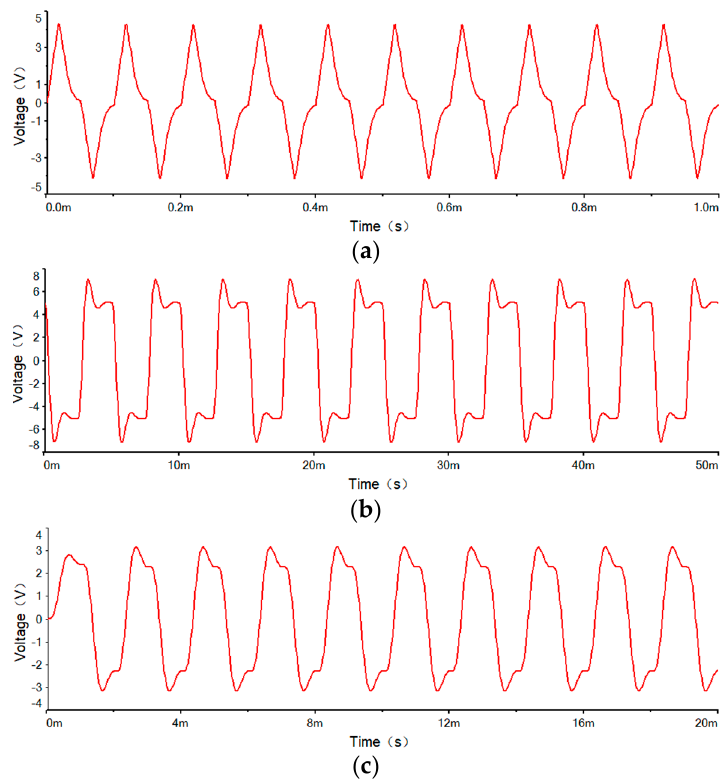
Figure 9. Responses of the CUT. ( a ) Response of the Sallen–Key bandpass filter circuit; ( b ) response of the CSTV filter circuit; and ( c ) response of the leap-frog low-pass filter circuit.